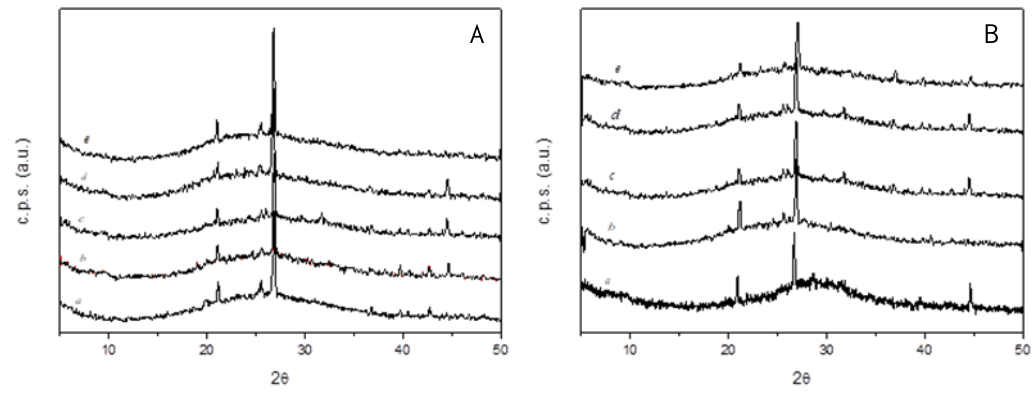
Figure 12. Diffractograms of geopolymeric mortars with ( A ) 0% wt of FBA and ( B ) 30% wt of FBA at: ( a ) as is and after thermal treatment at ( b ) 200 °C; ( c ) 400 °C; ( d ) 600 °C); ( e ) 700 °C.